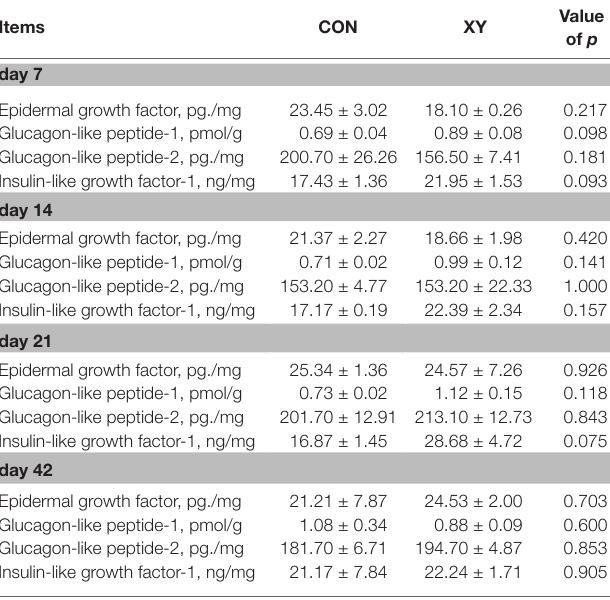
TABLE 8 | Effects of AT-xynA on ileal endocrine peptide concentrations of broilers. 1 Items CON XY